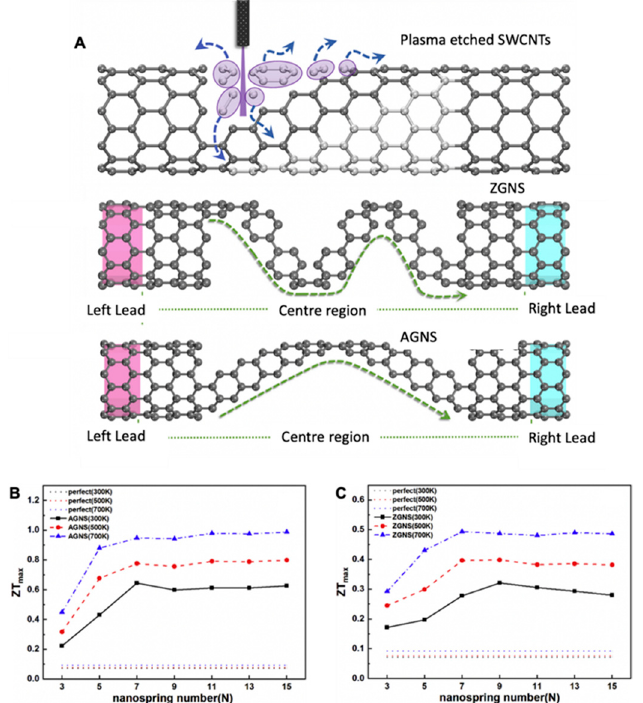
Figure 7. ( A ) Schematics of plasma-etched SWCNTs; thermoelectric ZGNS-modified SWNTs; AGNS-modified SWCNTs; ( B , C ) ZT of AGNS-modified SWCNTs in comparison with pristine CNTs, reprinted from [88], copyright (2020), Xu, X.; Xiao, H.; Ouyang, T.; Zhong, J. with permission from Elsevier.